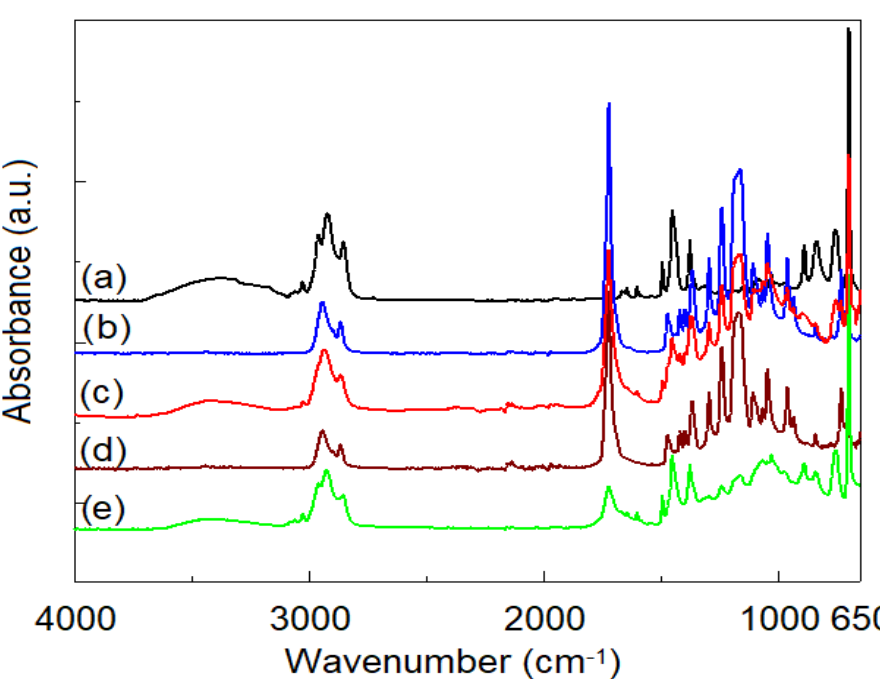
Figure 11. ATR/FTIR spectra recorded on: (a) SIS neat; (b) PCL neat; (c) SIS:PCL = 1:1; (d) SIS:PCL = 1:3; (e) SIS:PCL = 3:1 (Dose: 100 kGy).